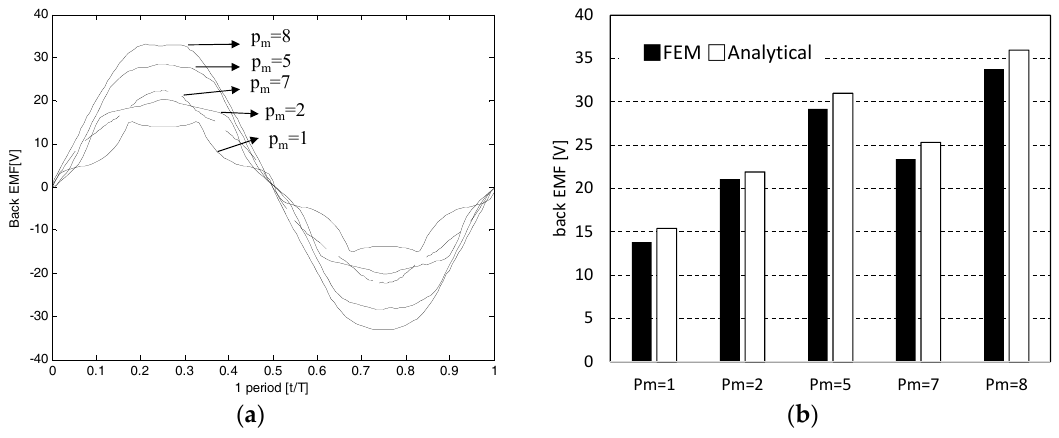
Figure 7. Comparison of Back EMF results. ( a ) Waveforms (FEM); ( b ) Magnitudes (FEM and analytical).